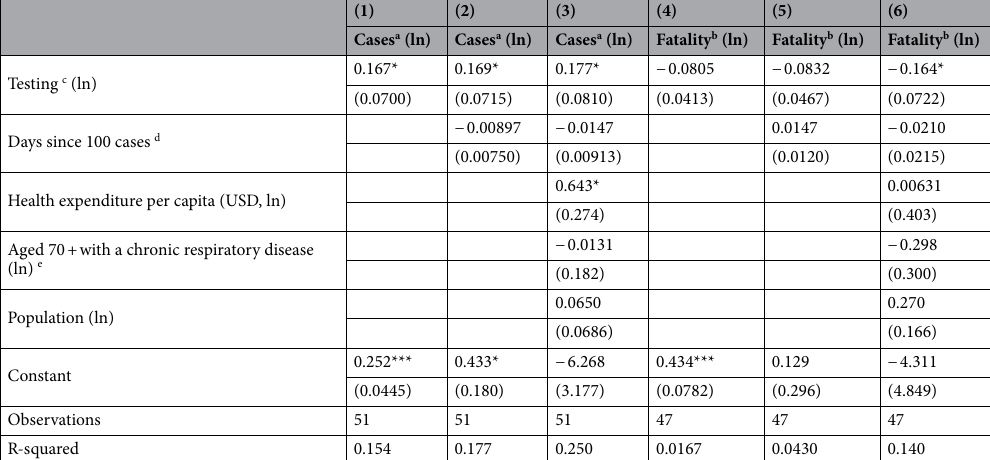
Table 2. USA regression estimates for the change in Covid-19 cases and case fatality rates reported by tests conducted by state in a week. * p < 0.05, ** p < 0.01, *** p < 0.001. Robust standard errors in parentheses. ln stands for natural logarithm. a Confirmed cases of Covid-19 ″ during the week ending April 10th, 2020. b Case fatality rate is the ratio between deaths due to Covid-19 and cases in the same period. c Testing is the amount of negative and positive tests informed to each country’s health authority in the same period of cases 30 . d The number of days since the cumulated number of cases was equal to or greater than 100 1 . e Share of the population aged 70 or older with a chronic respiratory disease, including chronic obstructive pulmonary disease and